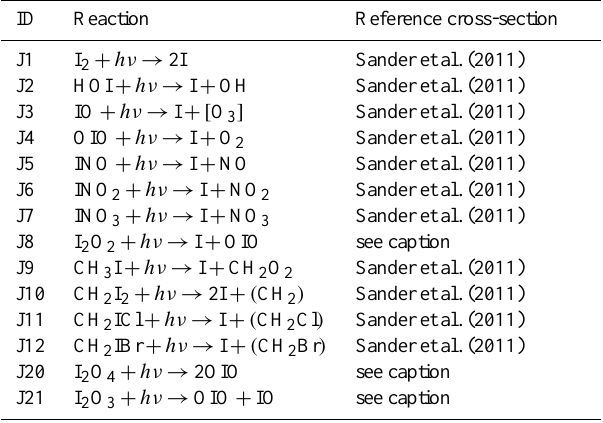
Table 5. Photolysis reactions of iodine species. For I 2 O X ( X = 2, 3, 4) the cross-section of INO 3 is used as described in Sect.